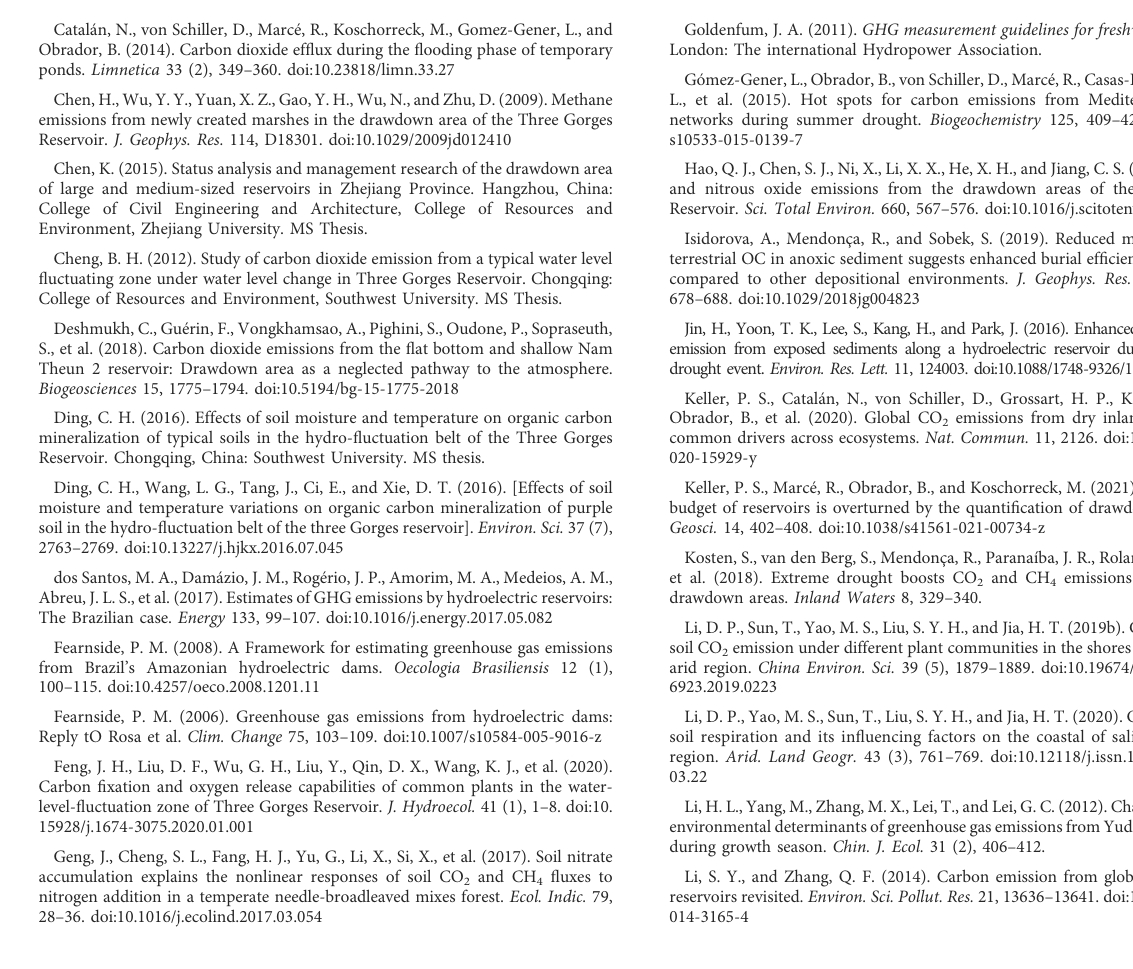
SUPPLEMENTARY FIGURE S1 Dynamic variation of CO 2 fl ux at the 148 m plot (A) and 149 m plot (B) of Zigui during the daytime in the fl ooded